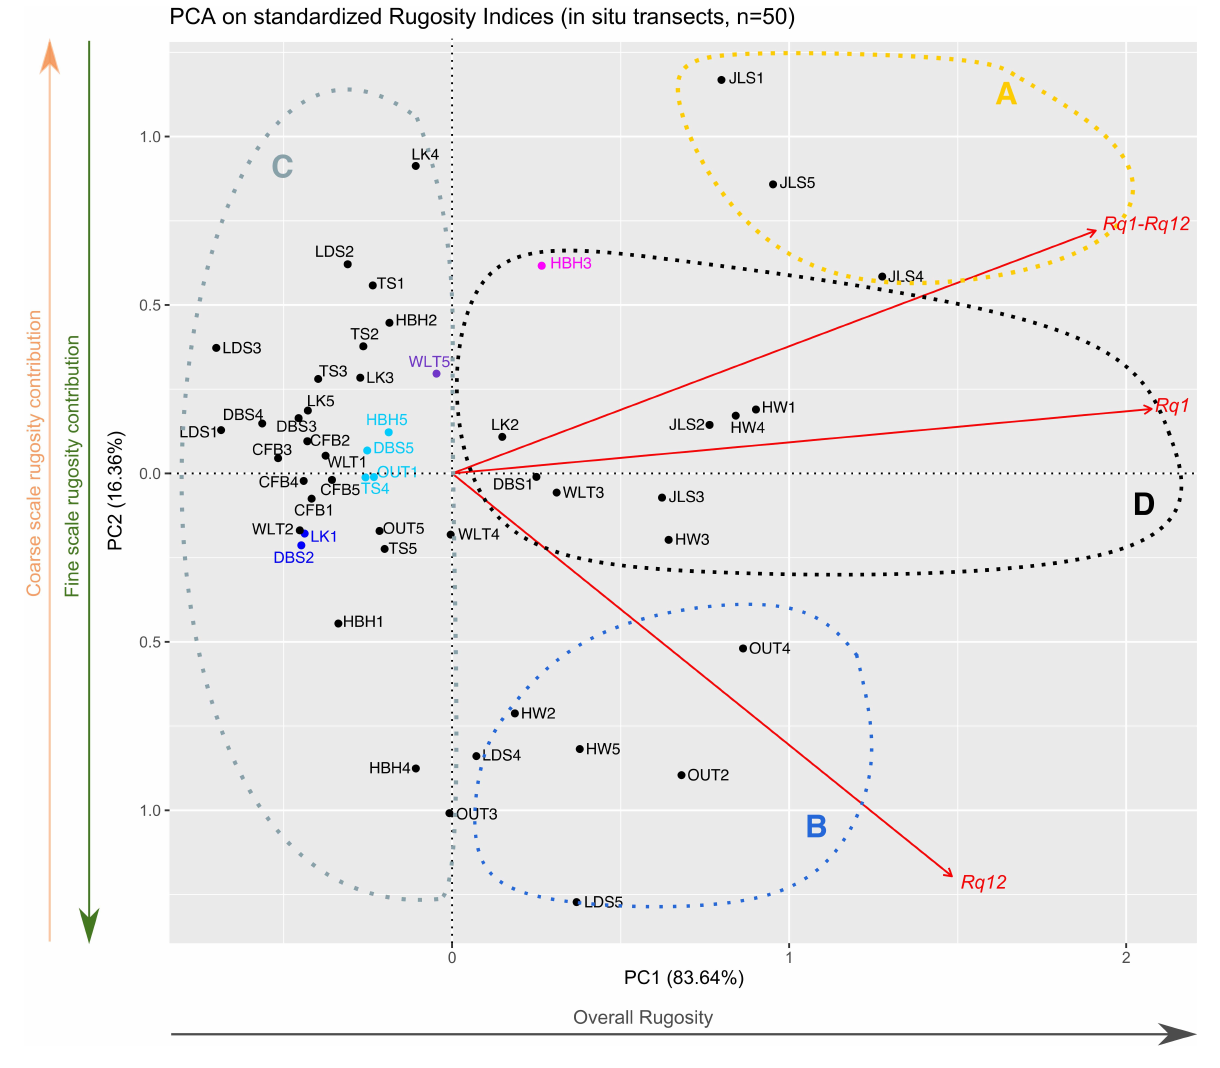
FIGURE 7 | PCA representation of rugosity indices for the 50 in situ ones. Red vectors represent the contribution of the rugosity indices to the PCA, while black and colored dots represented the transects used in this study. The eight colored dots (navy blue, cyan, purple, and fuchsia) represent transects that were used as examples in the “Results” section (Importance of Using Multiple Rugosity Indices and Distinguishing Among Types of Rugosity). The gray arrow under the x -axis illustrates the overall rugosity gradient between transects, while the green and orange arrows besides the y -axis represented the fine and coarse scale rugosity gradients, respectively. Dashed circles represent the proposed target transects used to illustrate potential management strategies in the